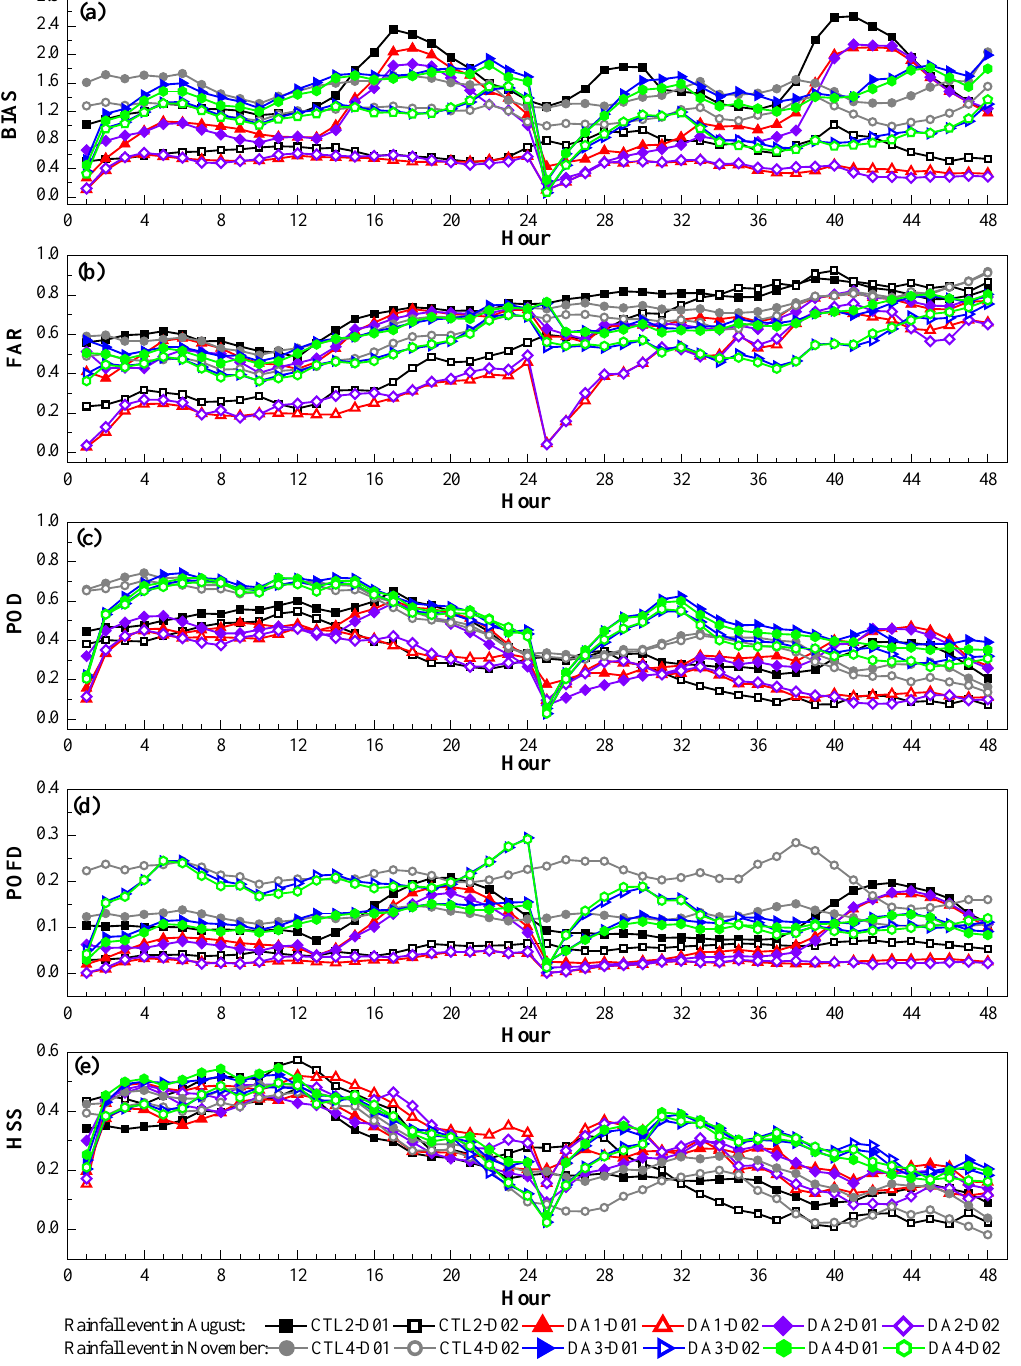
Figure 7. Skill scores of BIAS ( a ), FAR ( b ), POD ( c ), POFD ( d ), and HSS ( e ) for the hourly precipitation (48 h in all during the study period for each event) obtained from the CLT2, CTL4, and DA experiments.